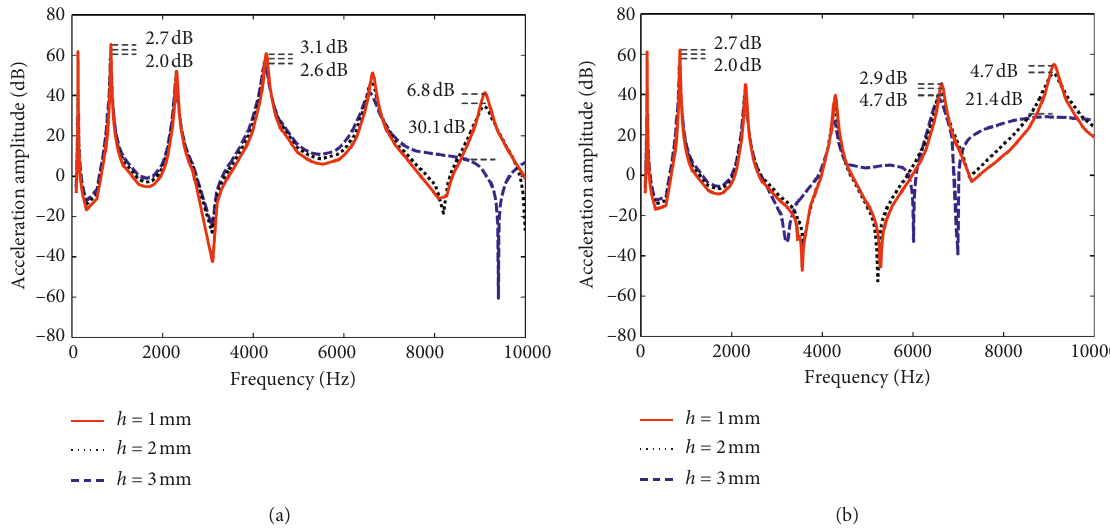
� 8 . 87 cm); (b) uniform beam region m